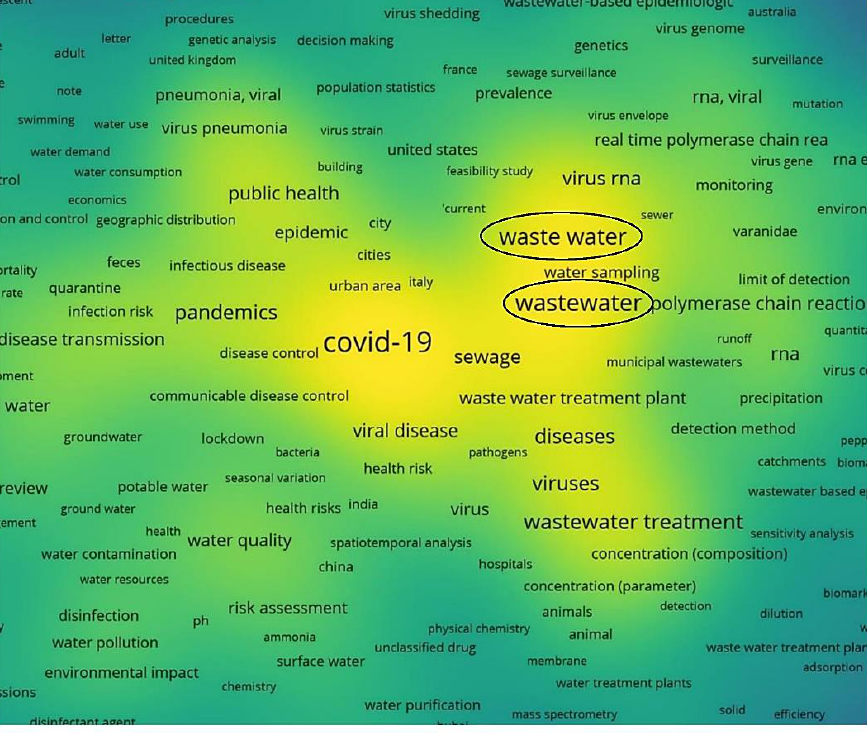
Figure 12. Density visualization map of the strongest relationship between COVID-19 and wastewater.